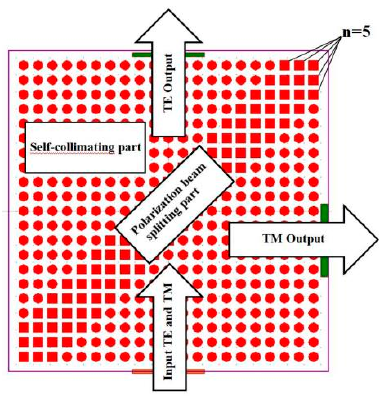
Figure 7. Compact polarization beam splitter